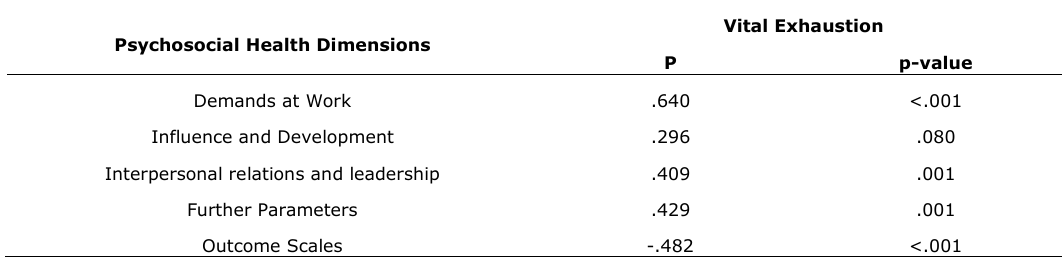
Table 5. Coefficients (p-values) of Spearman’s rho correlation between vital exhaustion and psychosocial health among off- shore personnel